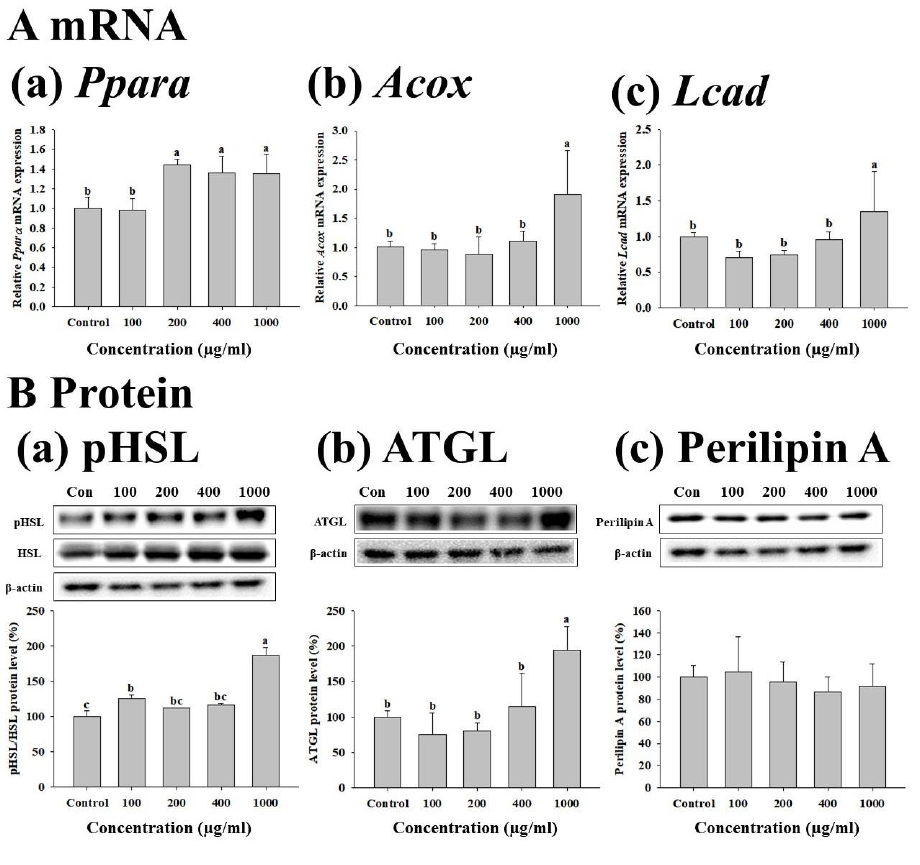
Figure 4. Effects of fermented white sword bean extract (FWSBE) on ( A ) transcription level of (a) Ppara , (b) Acox , and (c) Lcad , and ( B ) the protein level of (a) pHSL, (b) ATGL, and (c) perilipin A in mature 3T3-L1 adipocytes. The cells were treated with FWSBE at various concentrations (100, 200, 400, and 1000 μg/mL) for 96 h. Values are presented as mean ± standard deviation. The statistically significant differences ( p < 0.05) between groups were determined by a one-way ANOVA and Duncan’s multiple range test. Different letters are used to indicate significant differences. Acox, acyl-coenzyme A oxidase; ATGL, adipose triglyceride lipase; HSL, hormone sensitive lipase; Lcad, long-